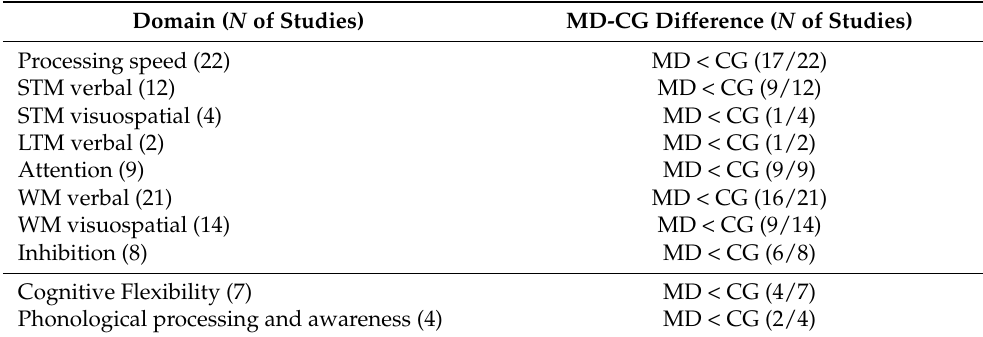
Table 1. Number of studies finding worse performance in the MD group than in the CG for each cognitive